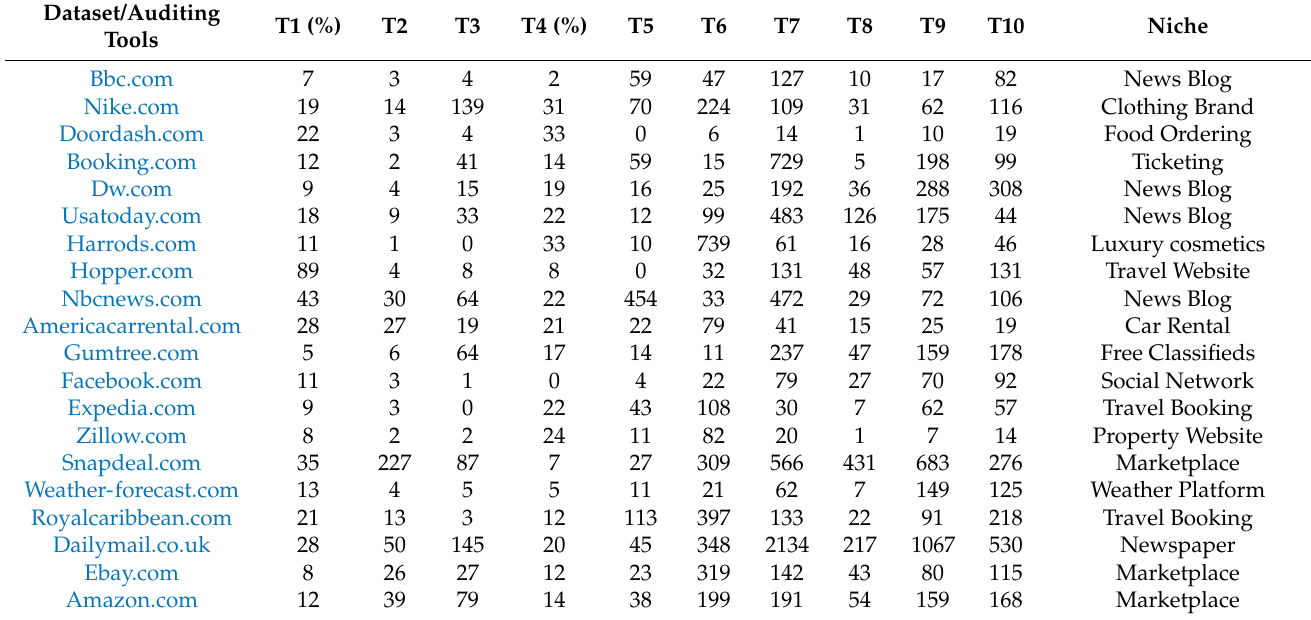
Table 4. Accessibility compliance errors for non-PWA